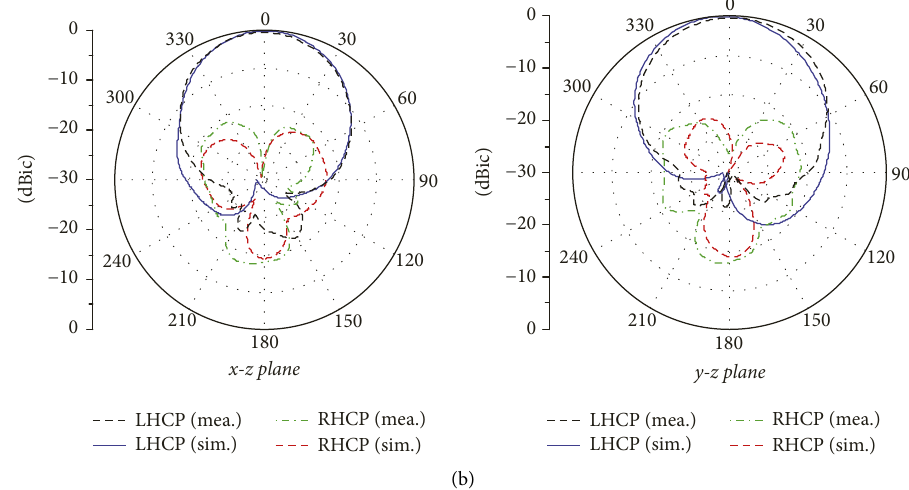
Figure 14: Simulated and measured radiation patterns of the antenna: (a) 3.9 GHz and (b)